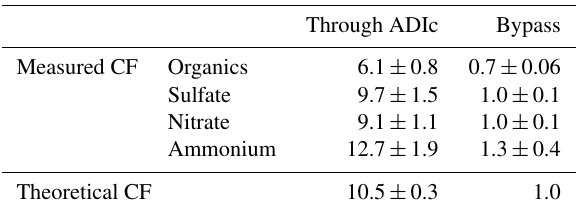
Table 3. Measured and theoretical concentration factors in ambient measurements at ARI. The measured CF was calculated from the ratio of Q-AMS + ADIc to HR-AMS mass loadings. In the bypass line the sample was not concentrated. The theoretical CF was cal- culated from the ADIc discard flow rate and the Q-AMS inlet flow rate (see text for